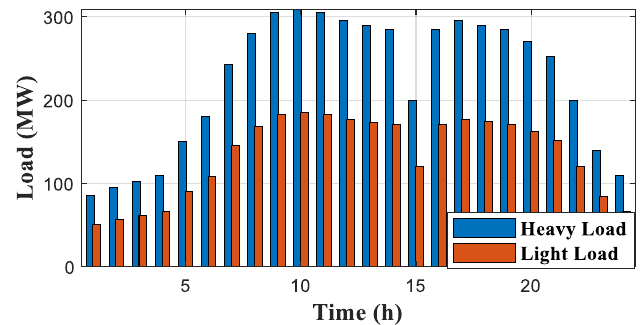
Figure 7. Hourly light load and heavy load profiles.